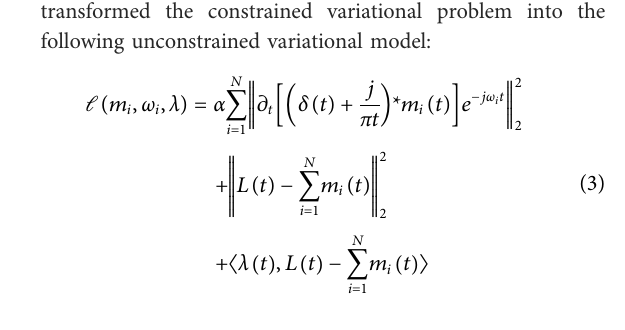
⎧⎪⎪⎪⎪⎪⎪⎪⎪⎪⎪⎪⎪⎨ ⎪⎪⎪⎪⎪⎪⎪⎪⎪⎪⎪⎪⎩ ^ λ k ( ω ) ^ L ( ω ) where ^ m k + 1 i ( ω ) , , and are respectively the Fourier transforms of m k + 1 i ( t ) , L ( t ) , and λ k ( t ) ; k is the number of iterations. When Eq. 5 is established, the iteration stops and the fi nal modal component is obtained.